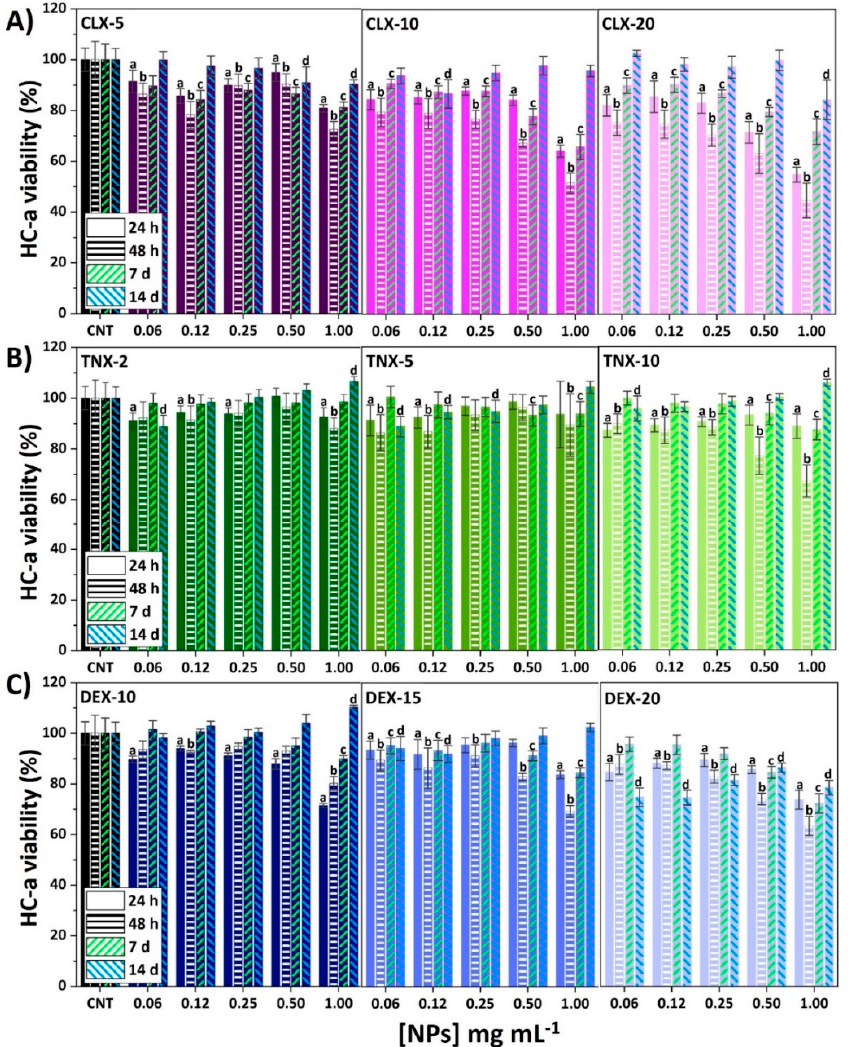
Figure 2. Effect of ( A ) CLX, ( B ) TNX and ( C ) DEX NPs on HC-a viability after 24 and 48 h, 7 and 14 days. Mean ± SD values are relative to control cells without NP treatment (CNT) for each time, in which cell viability was taken as 100%. ANOVA of the results was performed with respect to their corresponding CNT at a significance level of p < 0.05 (a, b, c and d correspond to statistical significance for 24 h, 48 h, 7 and 14 days samples,